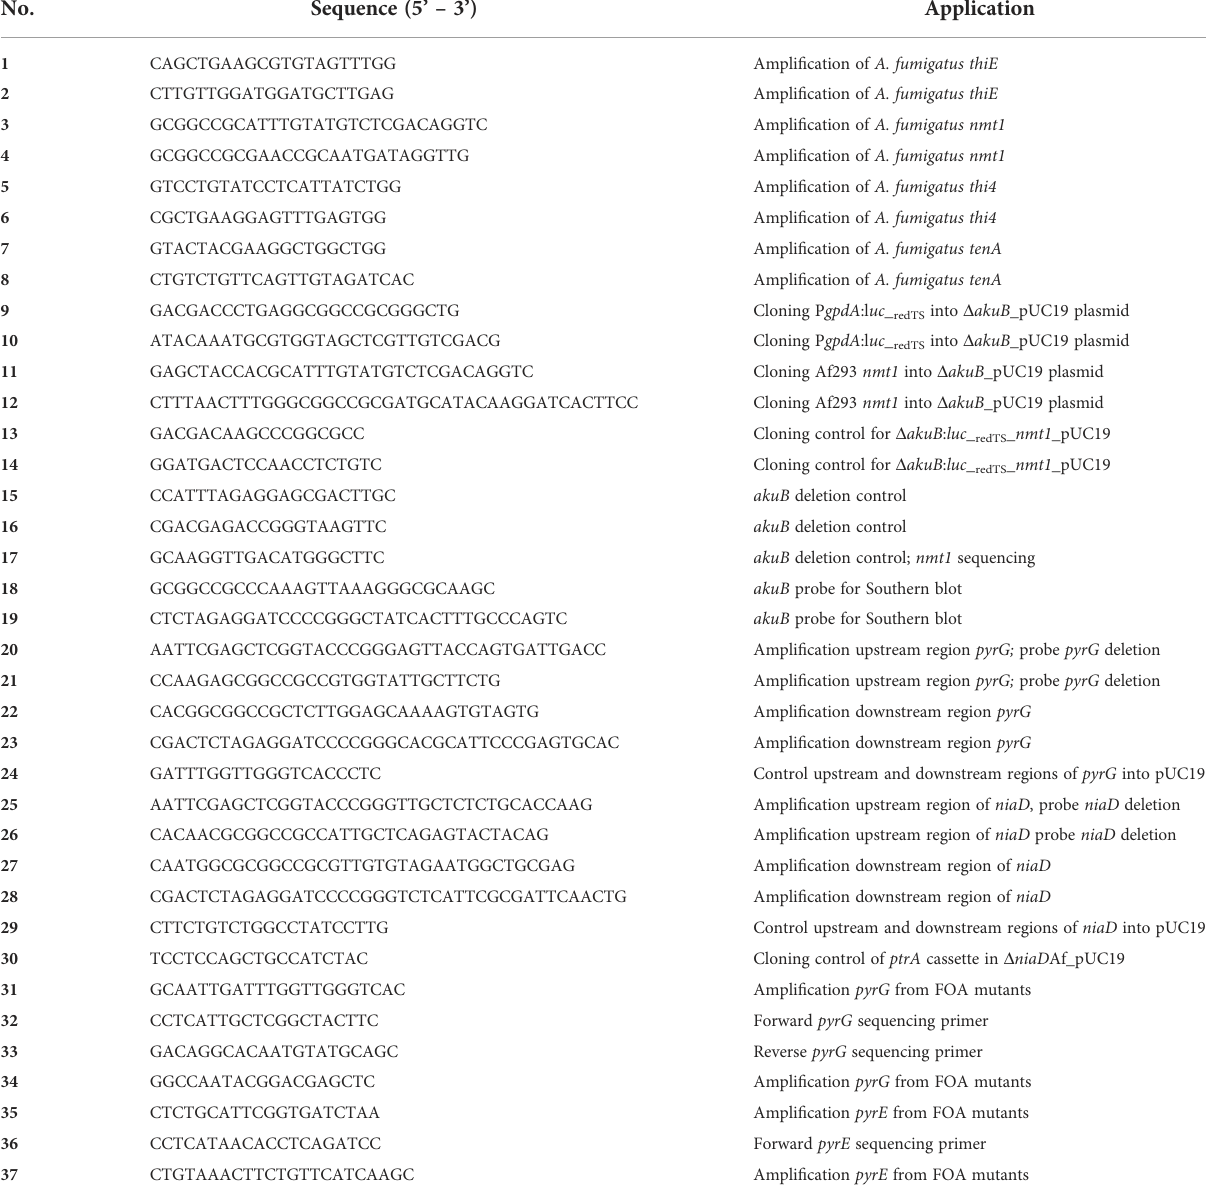
TABLE 1 Oligonucleotides used in this study.